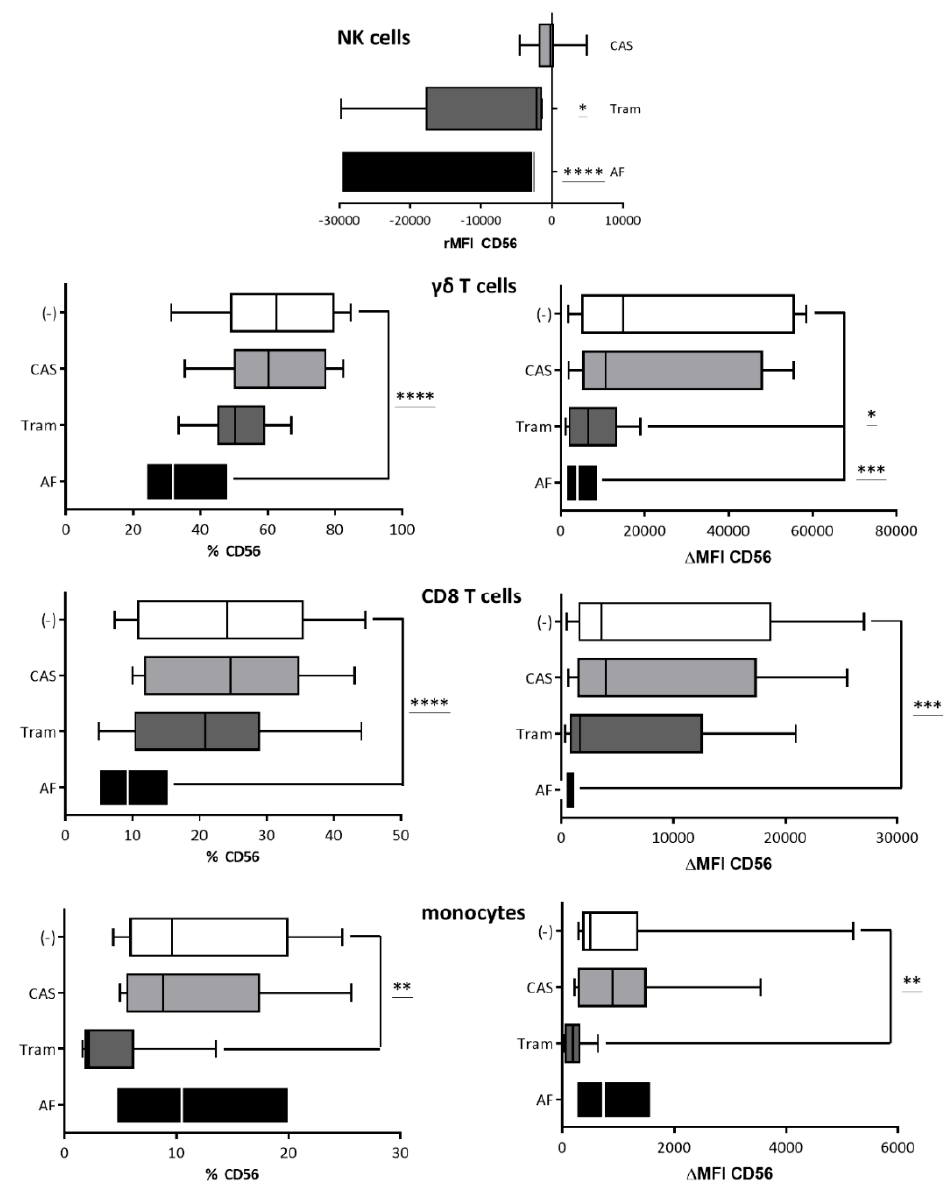
Figure 7. The effect of the selective inhibition of the interleukin (IL)-15 signaling pathways on Cluster of differentiation (CD)56 expression. Peripheral blood mononuclear cells (PBMCs) were cultured in IL-15 (10 ng/mL) containing medium ( − ) in the presence of CAS 285986-31-4 (1 µM; CAS), trametinib (1 µM; Tram) or afuresertib (2 µM; AF) for 48 hours (Natural killer (NK) cells, monocytes) or 1 week ( γδ T cells, CD8 T cells). The percentage CD56-postive cells are shown, as determined by flow cytometry, as well as the Δ MFI) of CD56 calculated by subtracting the “background” MFI of the isotype control from the MFI of the sample. Concerning NK cells, the MFI of the IL-15 medium ( − ) control was subtracted from the MFI of the sample (rMFI). Data are represented as boxes and whiskers (10–90%) of 9 independent donors. One-way ANOVA with Bonferroni’s multiple comparison test or Friedman test with Dunn’s multiple comparison test were used. **** p < 0.0001; *** p < 0.001; ** p < 0.01; * p < 0.5.